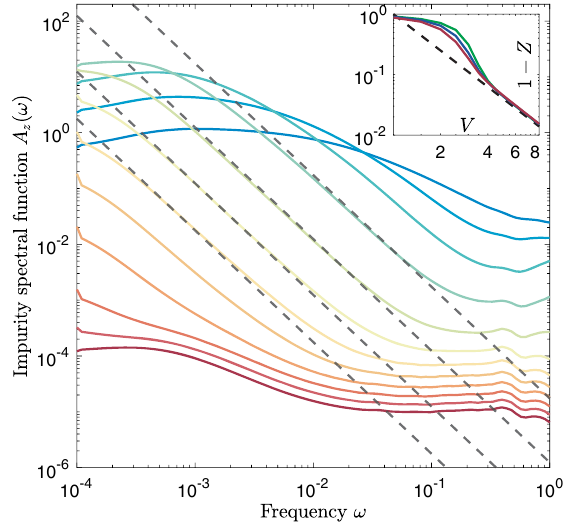
FIG. 10. Impurity spectrum. For impurity potentials ranging from V ¼ 1 to V ¼ 8 , the spectral function of the impurity is shown from blue to red in a system of L ¼ 17 spins. Dashed lines are guides for the eye and indicate 1 = ω 2 scaling. The inset shows 2 (cid:2) with the expectation over all 1 − Z , where Z ¼ 4 E ½h n j S z 0 j n i eigenstates and realizations of the weak